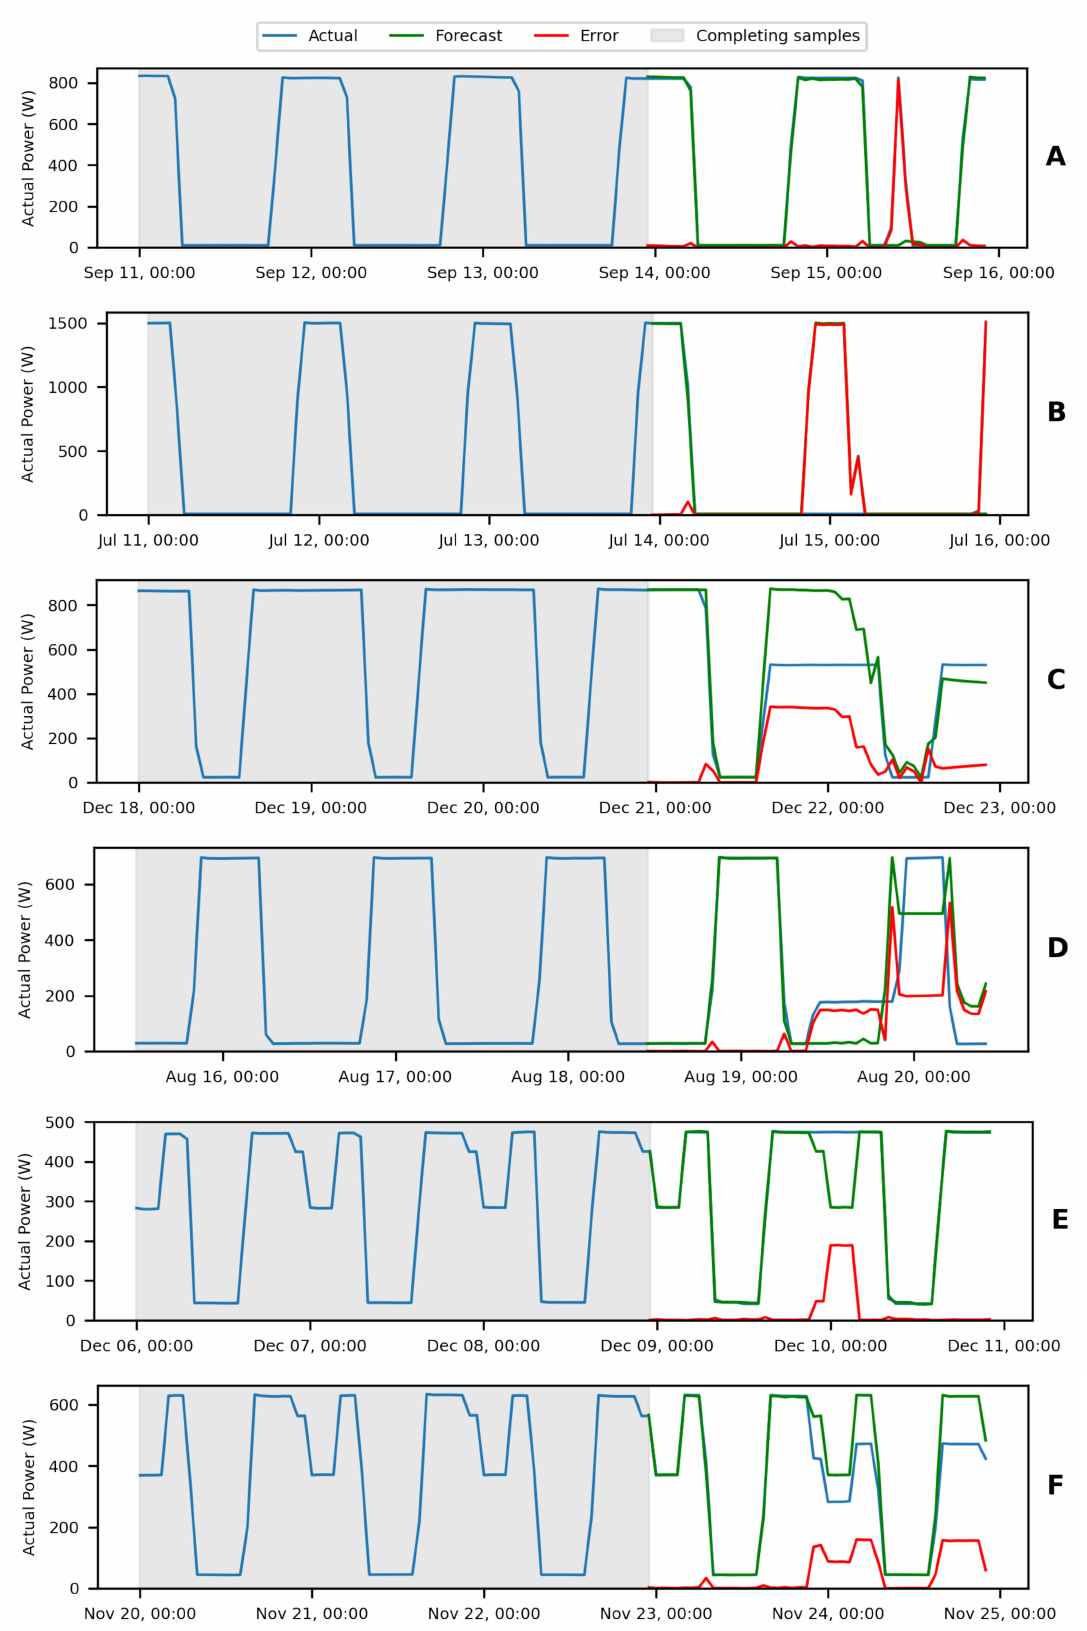
Figure 12. Simulation results for each type of anomaly. Subfigures ( A – F ) correspond to anomalies discussed in Section